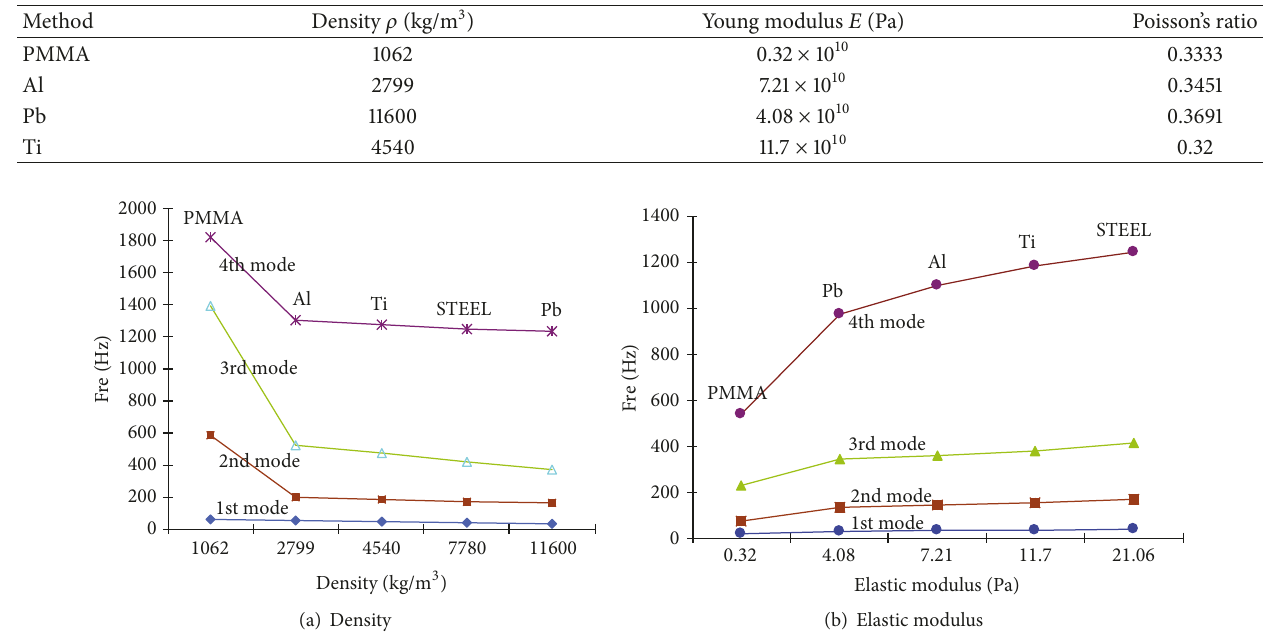
Figure 7: Effect of material